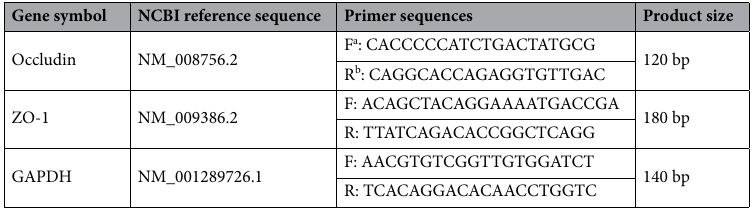
Table 2. Primer sequences of quantitative real-time PCR. a Forward primer. b Reverse